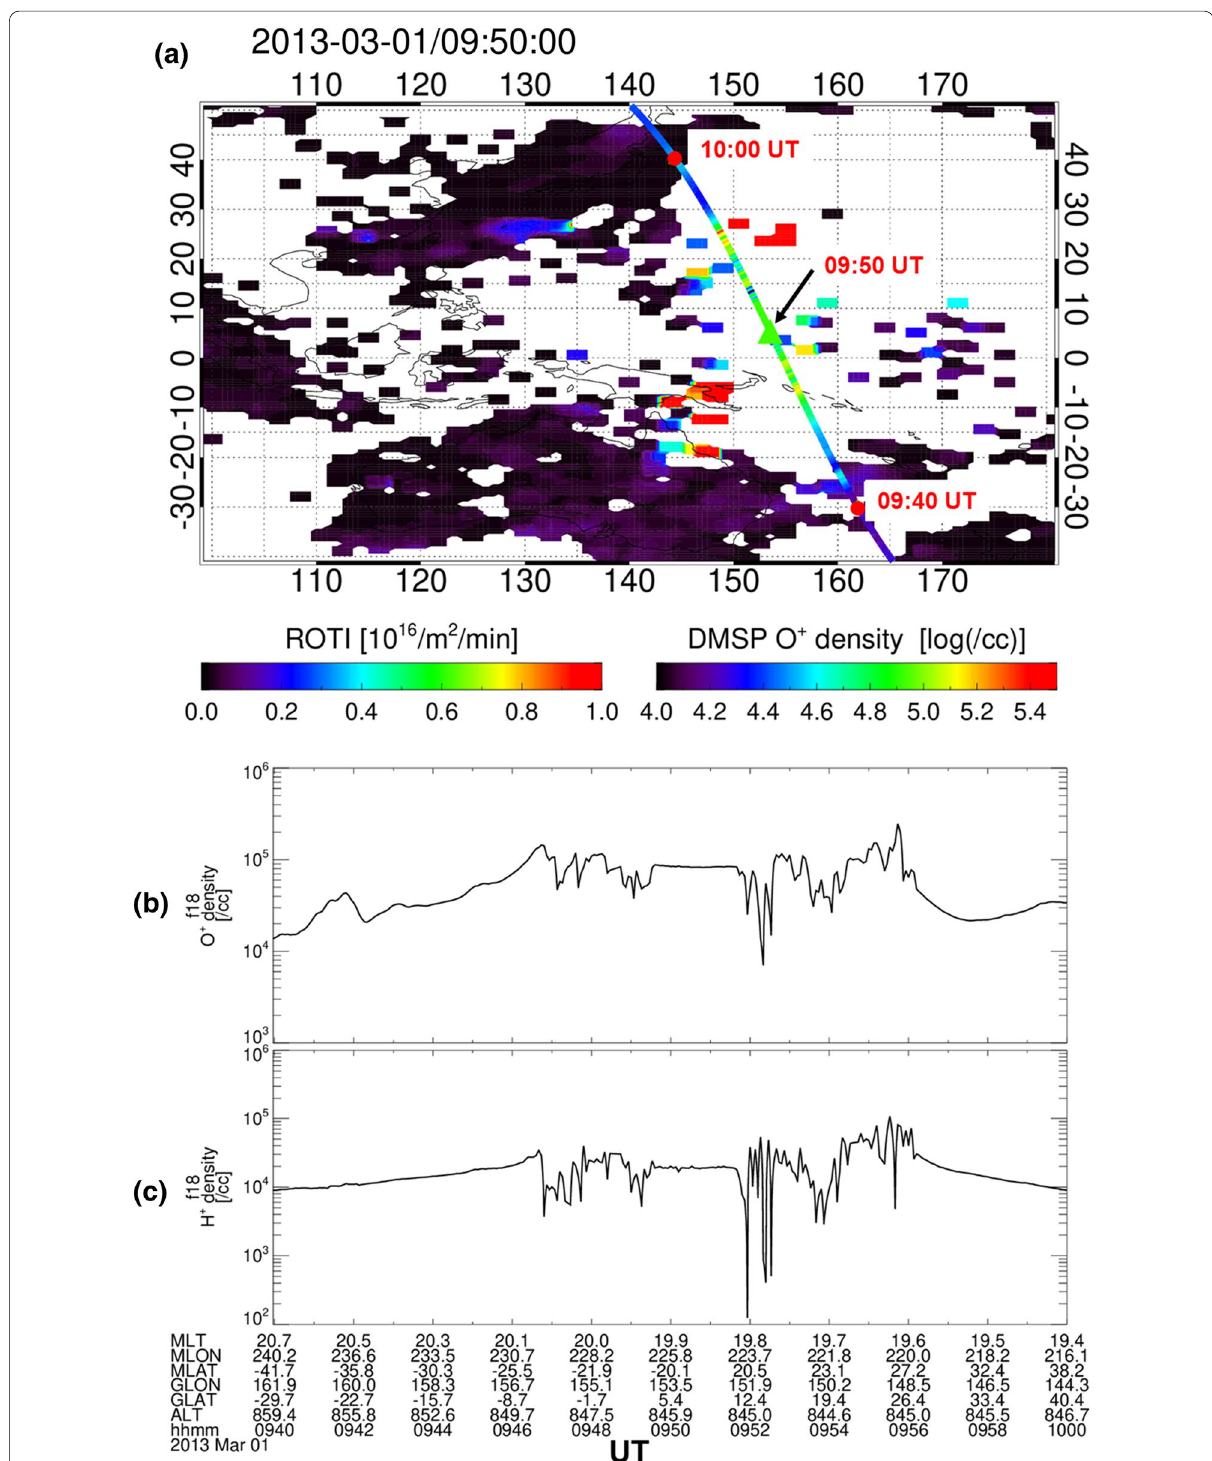
Fig. 3 Panel a Two-dimensional maps of ROTI and O + density observed by the DMSP F-18 satellite near Japan and Australia at 09:50 UT on March 1, 2013. The curve indicates O + density along the DMSP satellite path around 09:50 UT. The left and right color codes indicate ROTI and O + density values observed by the DMSP satellite, respectively. The triangle and red circles on the path indicate the DMSP satellite locations at 09:50 UT and 09:40 and 10:00 UT, respectively. Panels b and c Time-series plots of O + and H + densities observed by the DMSP F-18 satellite during 09:40–10:00